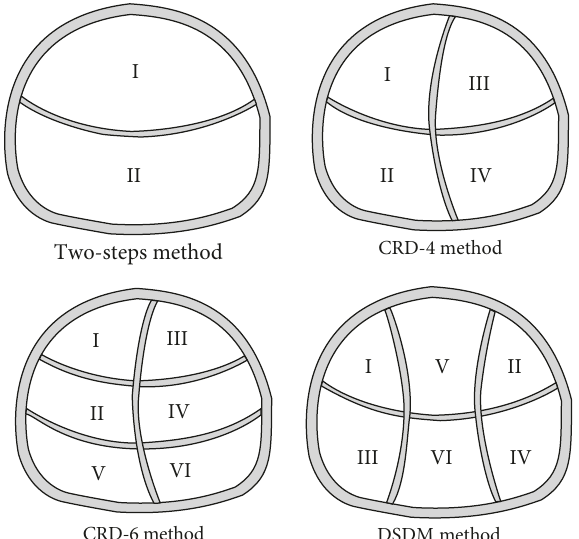
Figure 5: Excavation step sequence of different excavation methods. (a) Two-step method. (b) CRD-4 method. (c) CRD-6 method. (d) DSDM